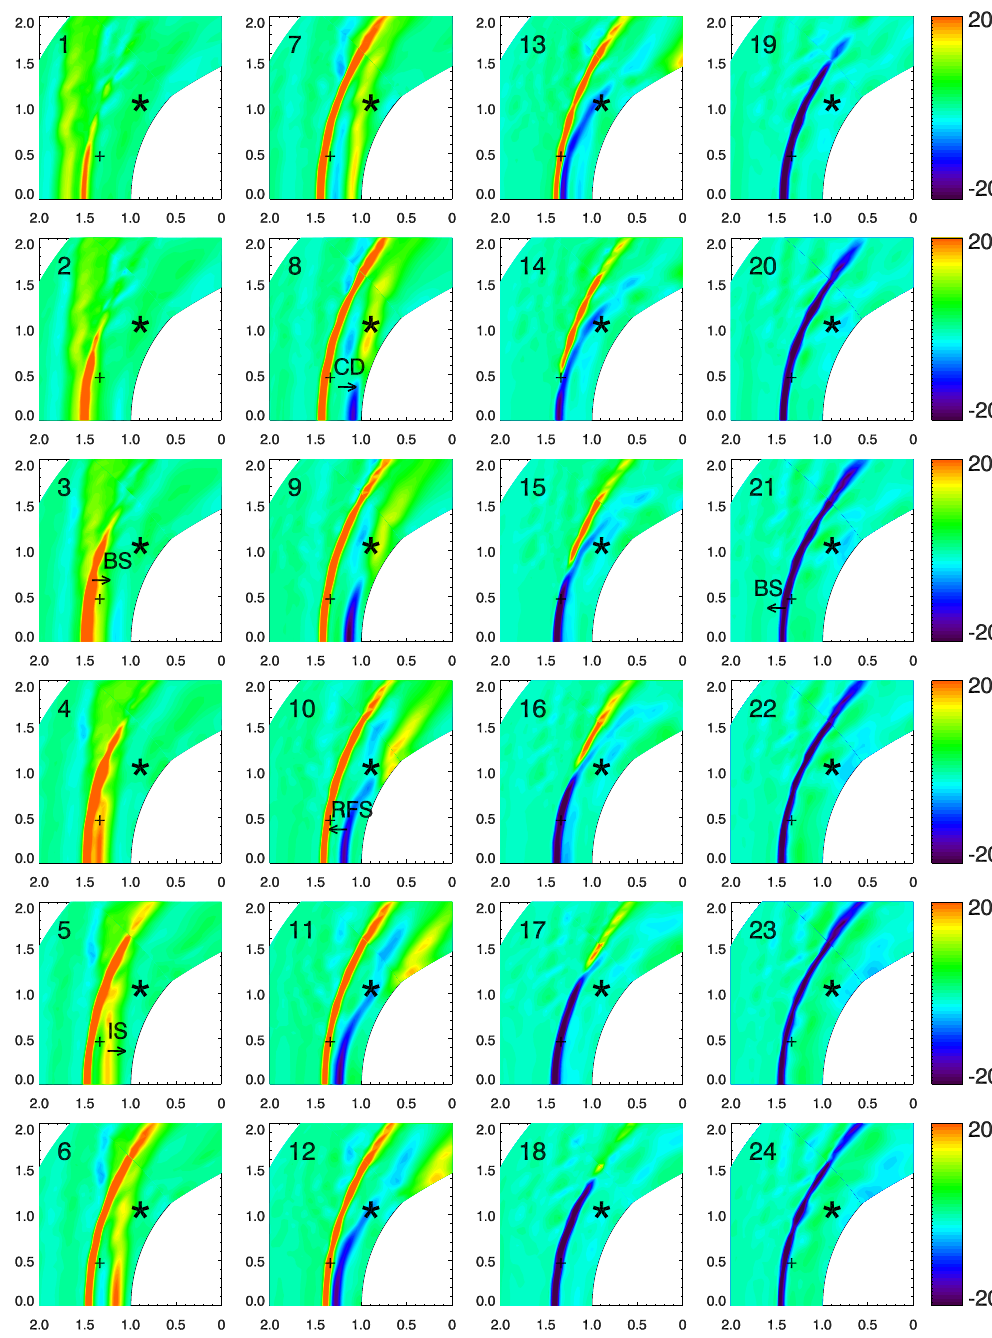
Fig. 9. Contours of 1V showing variations of velocity. The format is the same as that in Fig.